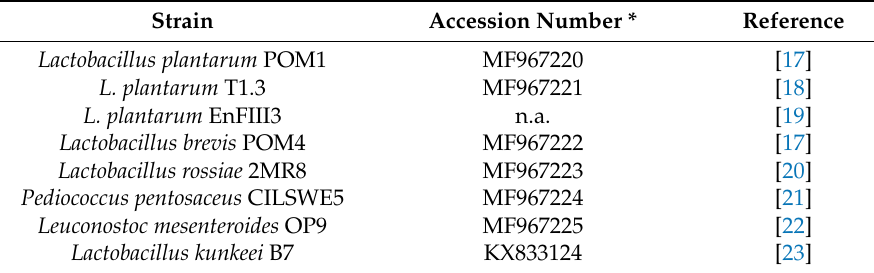
Table 1. Lactic acid bacteria strains ( n = 8) used in this